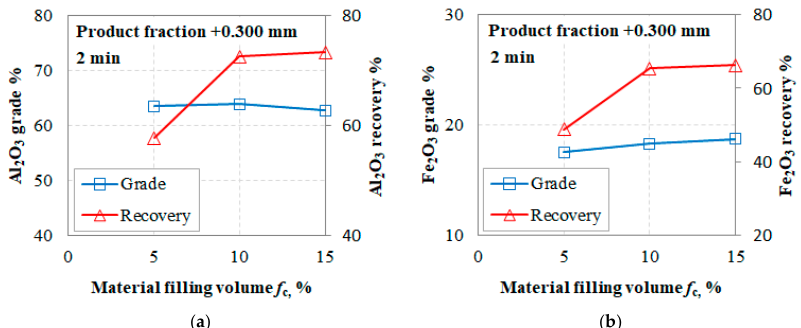
Figure 8. Effect of material filling volume f c on ( a ) Al 2 O 3 grade and recovery and ( b ) Fe 2 O 3 grade and recovery for the product fraction coarser than 0.300 mm after 2 min of grinding.